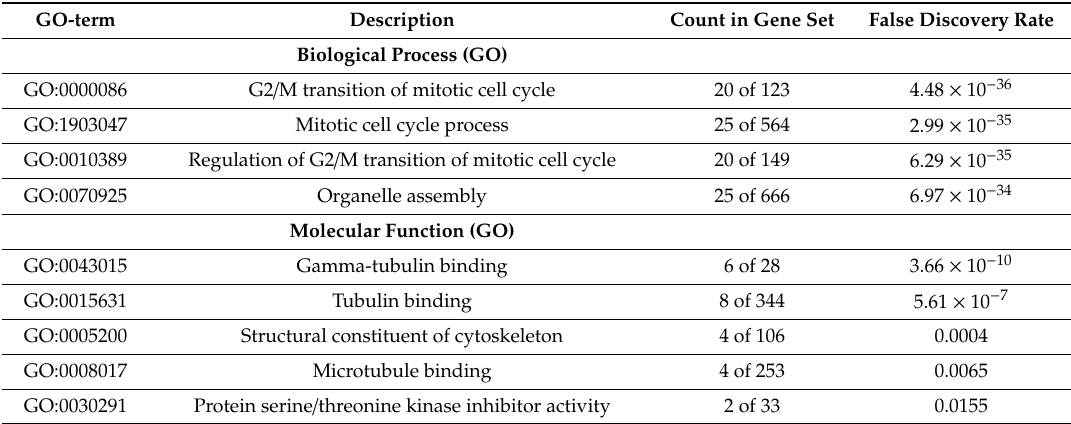
Table 12. STRING: Biological Process (GO), Molecular Functions (GO), Cellular Components (GO) with KEGG, and Reactome Pathways for the TUBGCP5